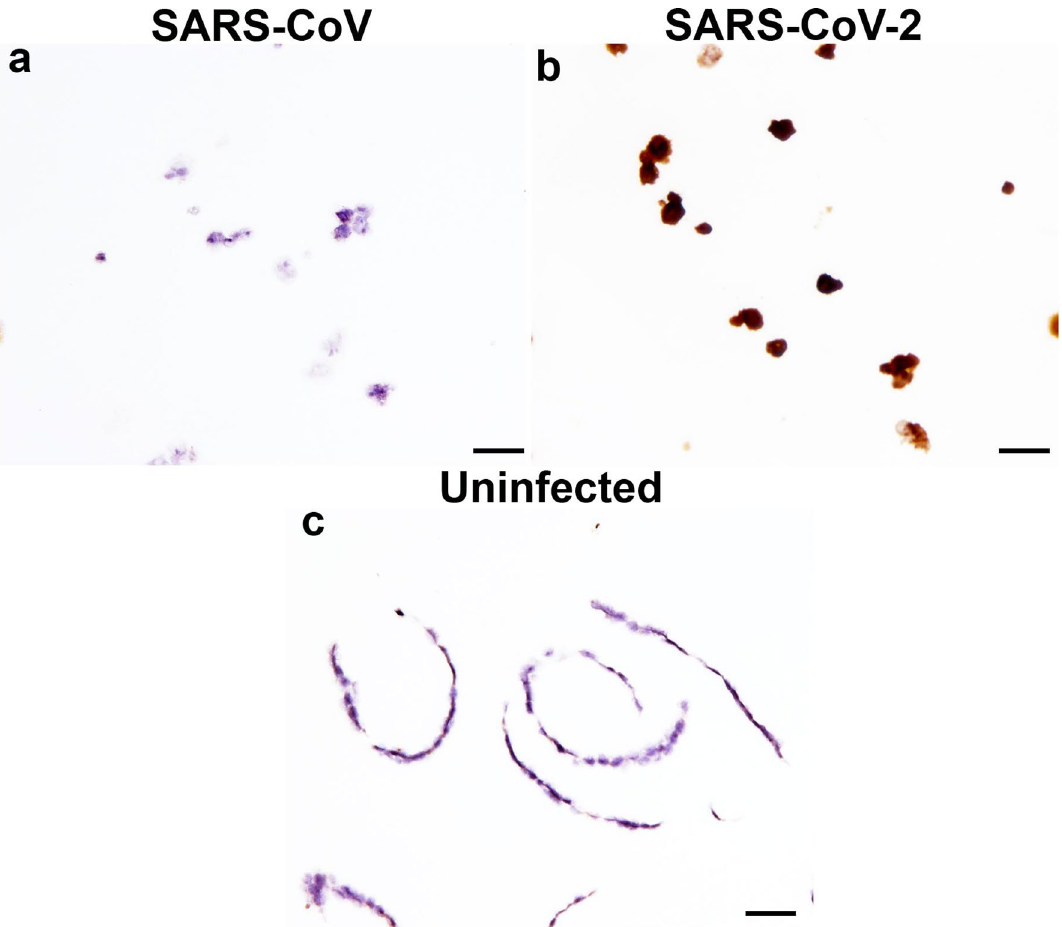
Figure 2. In situ hybridisation (ISH) of FFPE cells infected with SARS-CoV and SARS-CoV-2 using RNAScope ® . ISH performed using RNA probes designed specific to SARS-CoV-2 spike RNA. SARS-CoV (a) and SARS-CoV-2 infected cells (b) , uninfected cells (c) . Scale bars, 20